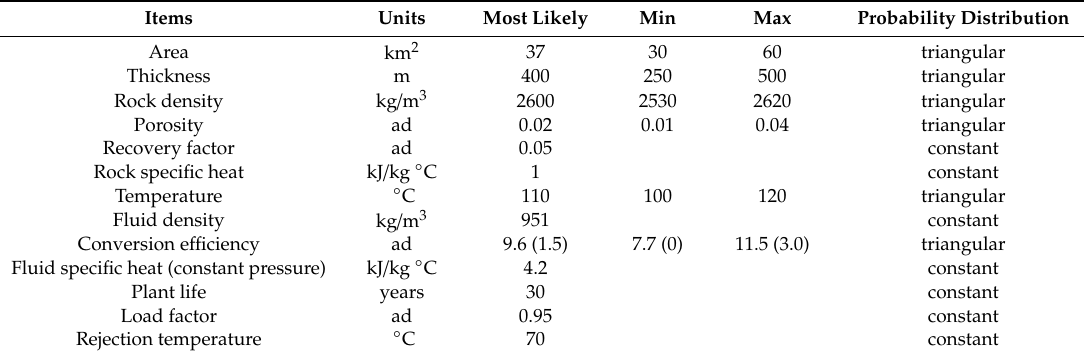
Table 4. Monte Carlo simulation for the Longroiva Spa site (ad = adimensional).